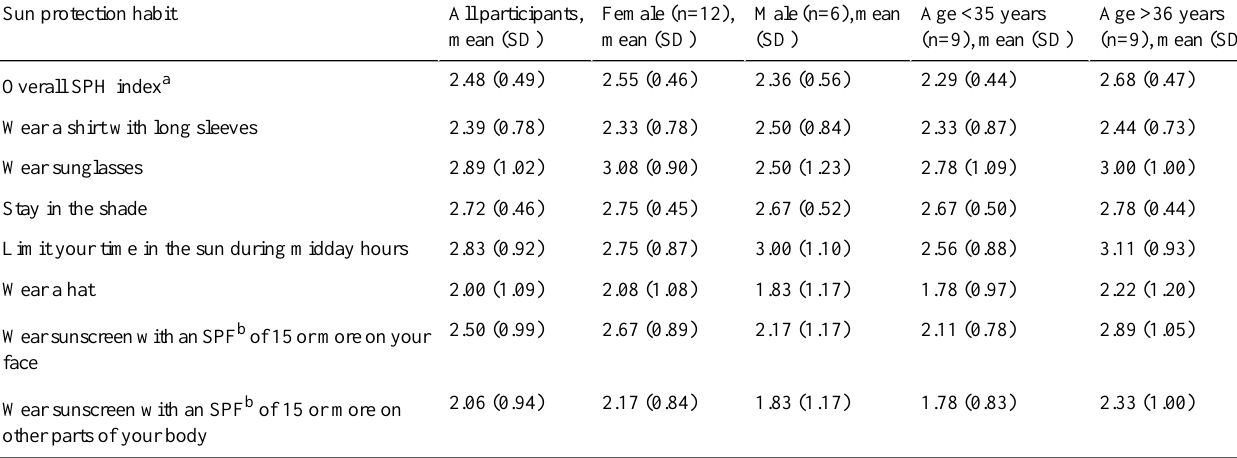
Table 2. End user focus group sun protection habits